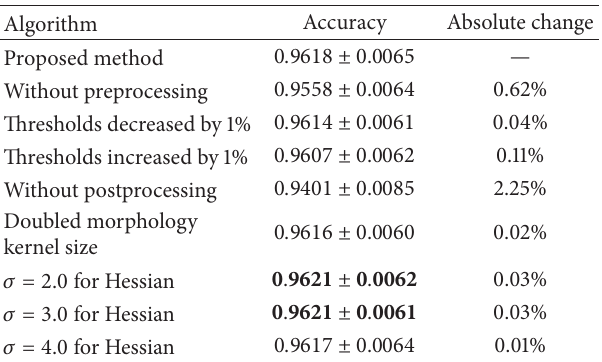
Table 8: Accuracy comparison of different settings using the high resolution fundus